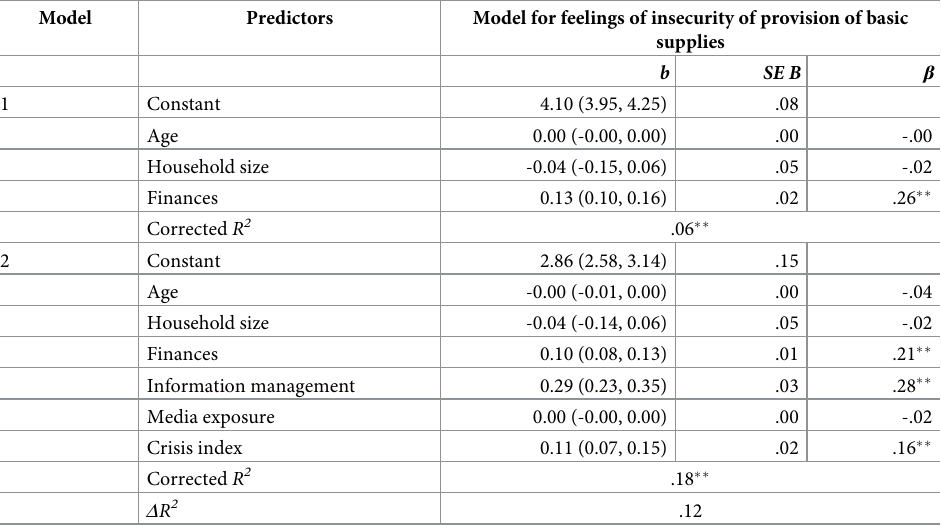
Table 5. Linear model of predictors of feelings of insecurity of provision of basic supplies.